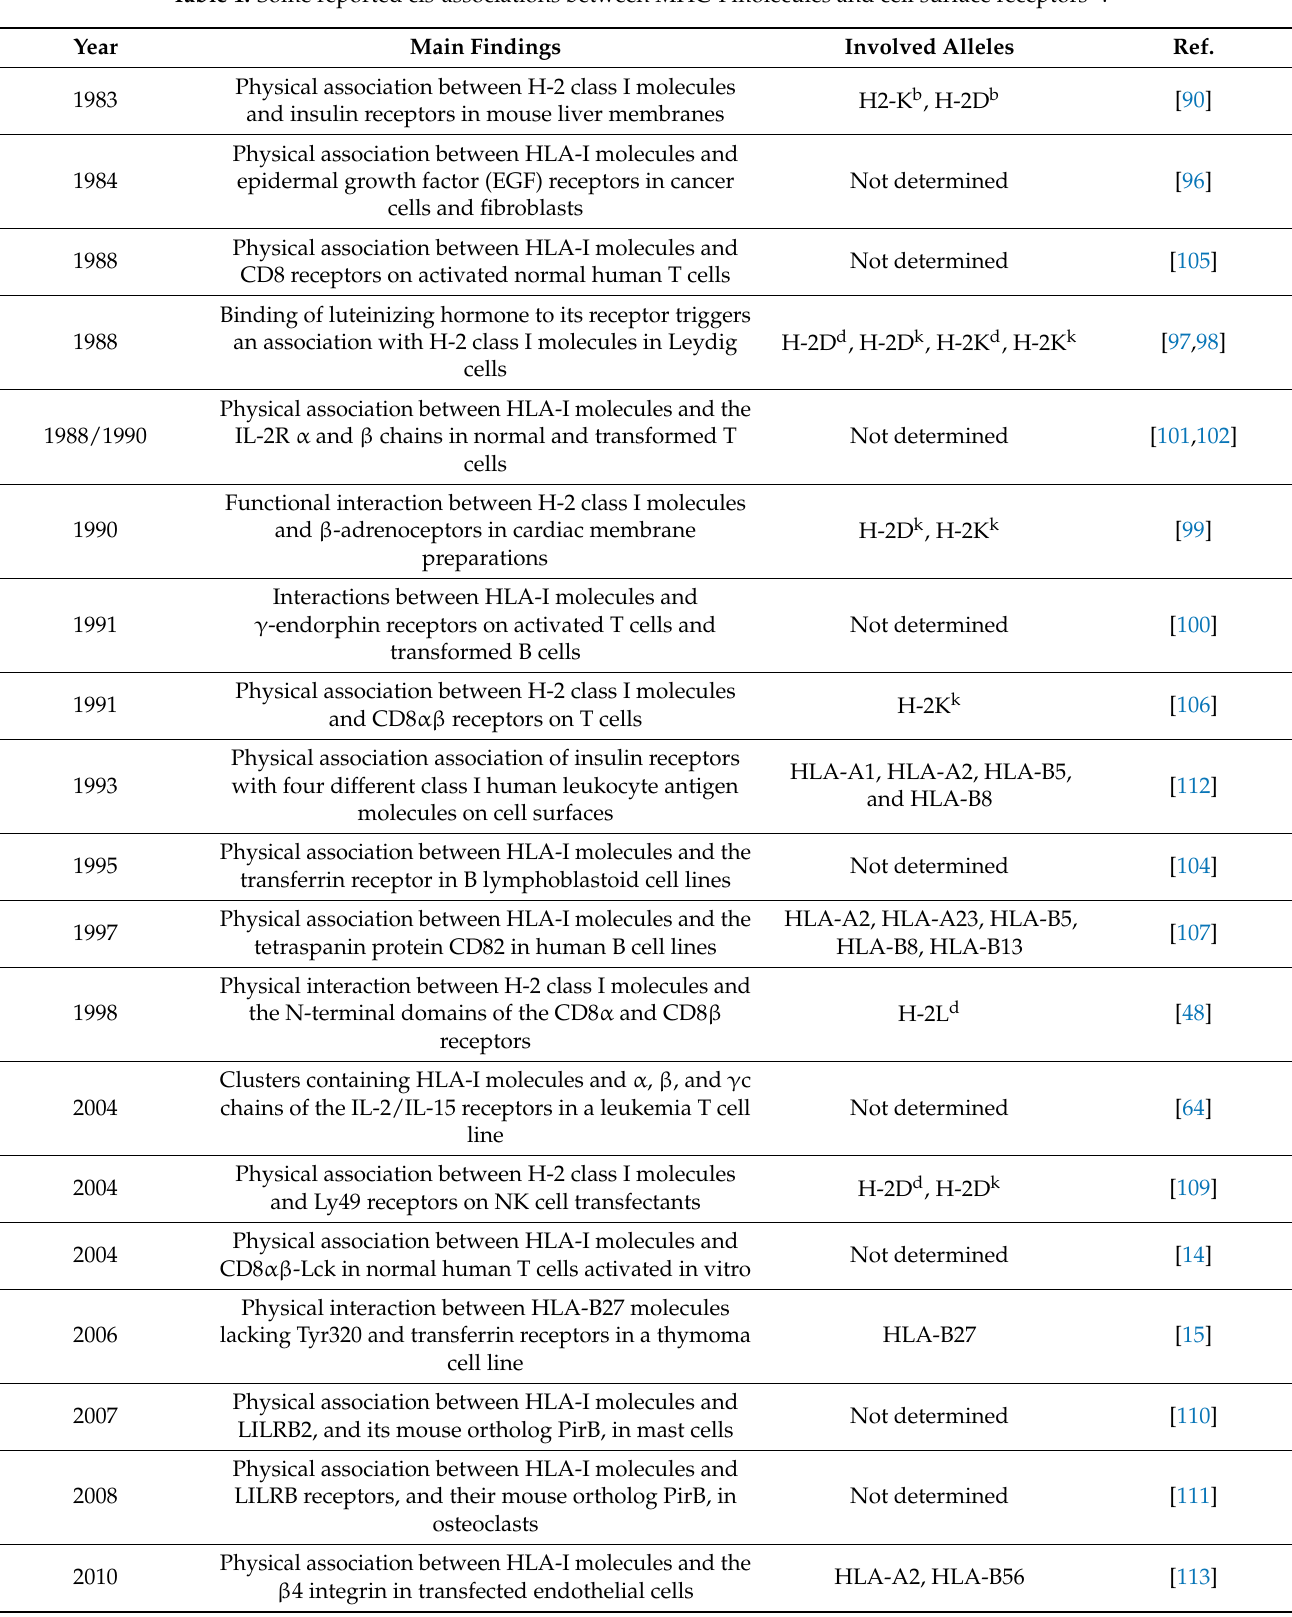
Table 1. Some reported cis-associations between MHC-I molecules and cell surface receptors *. Year Main Findings Involved Alleles